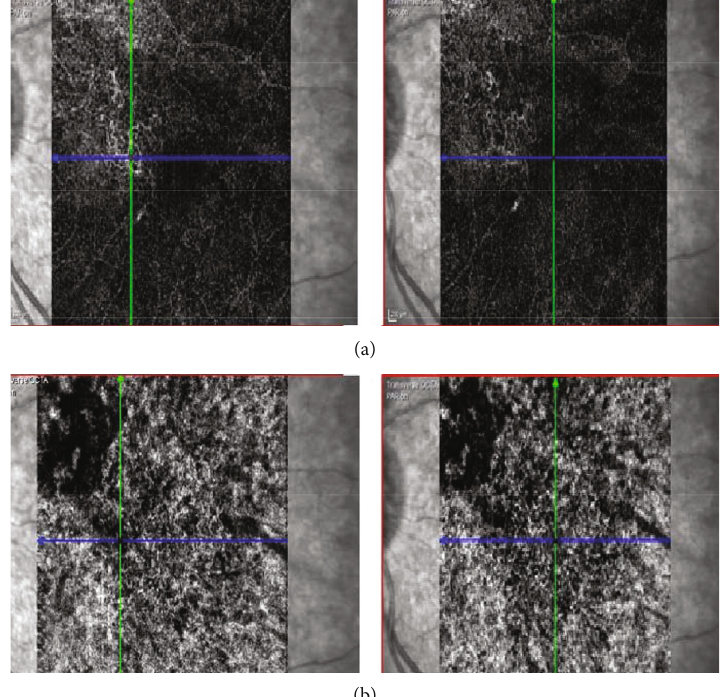
Figure 7: Comparison of baseline optical coherence tomography angiography (OCTA; nonexudative state) and OCTA at the time of submacular fl uid (exudative state). Note the slight increase in the size of the vascular network in avascular slabs and the appearance of new dilated vessels in choroidal